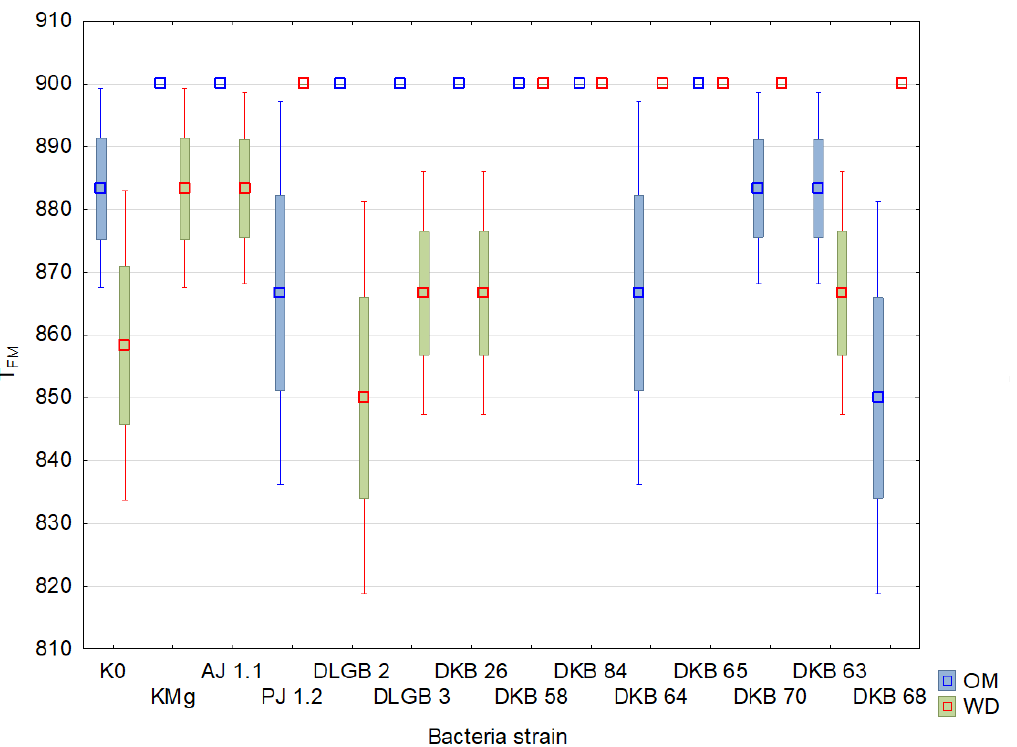
Figure 7. F V /F M in the leaves of strawberry plants inoculated with rhizosphere bacteria growing under different substrate moisture levels, where: OM — optimal moisture, WD — water deficit.